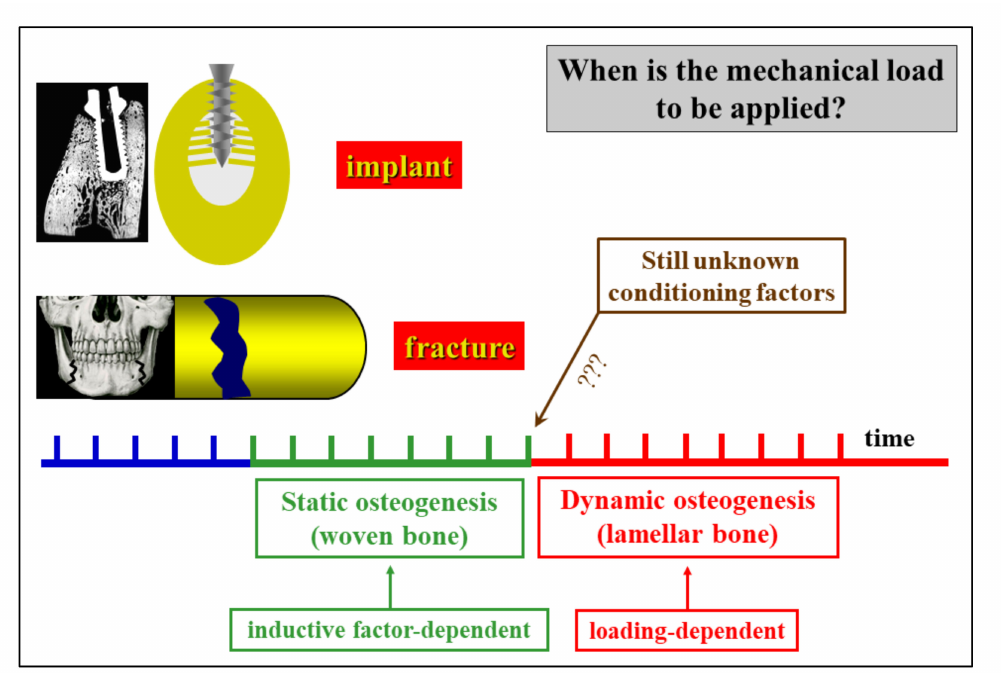
Figure 13. Schematic drawing with regard to the translational meaning of SO versus DO (see text for explanation). A key aspect to be clarified in the near future is the duration time, in different